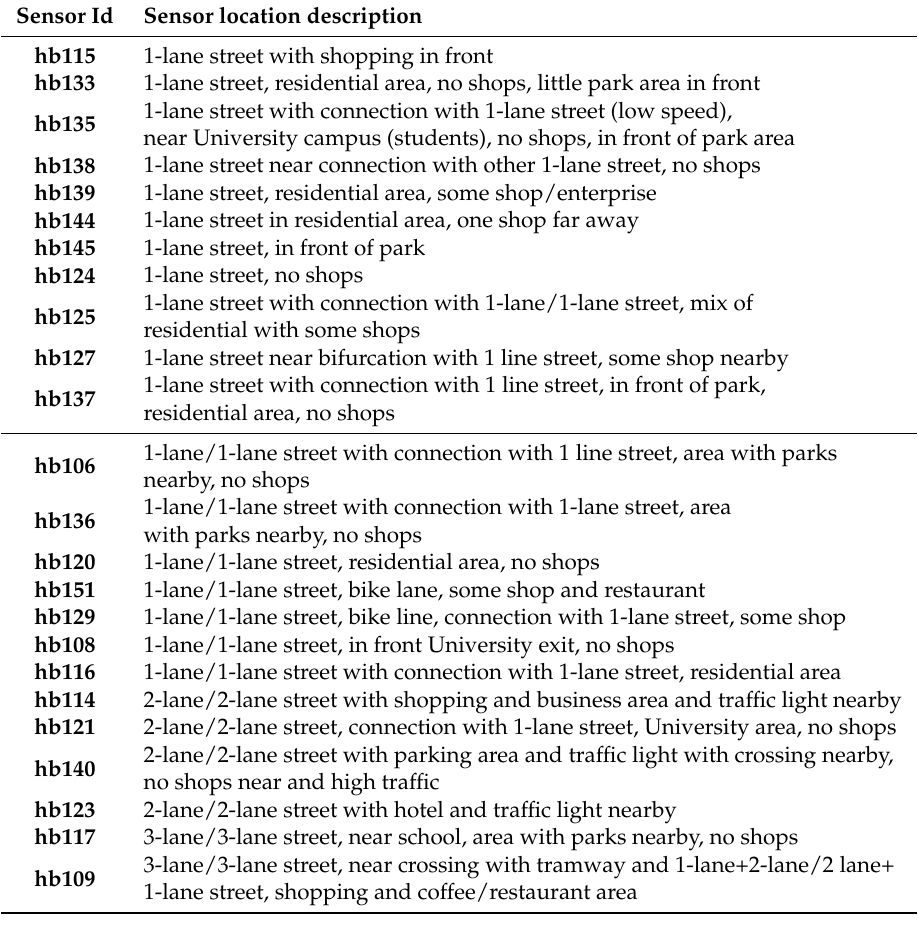
Table 1. Description of the sensors’ location across District 9 of Milan as the pilot urban area of the DYNAMAP project [38], differentiating between those located in narrow streets (1 lane) and wide streets (more than 1 lane) by means of a horizontal line. X-lane/Y-lane street stands for a two-way street that has X lanes in one-way and Y lanes in the opposite way. X-lane street stands for a street with X lanes in the same